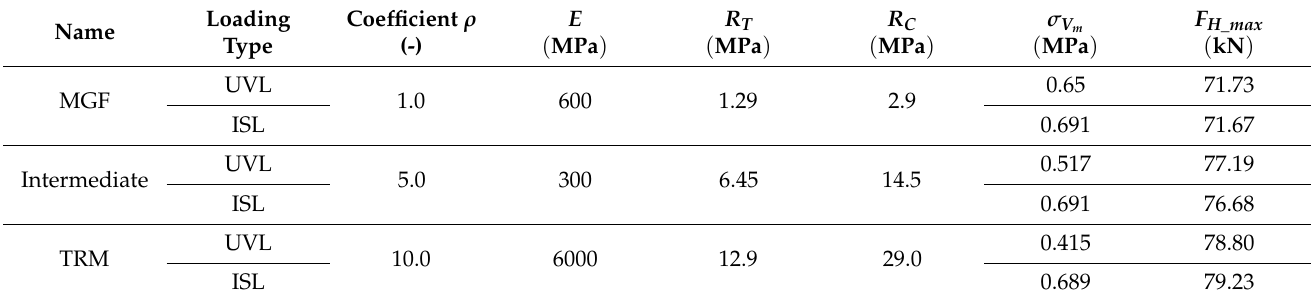
Table 6. Properties of the three configurations tested and main results.